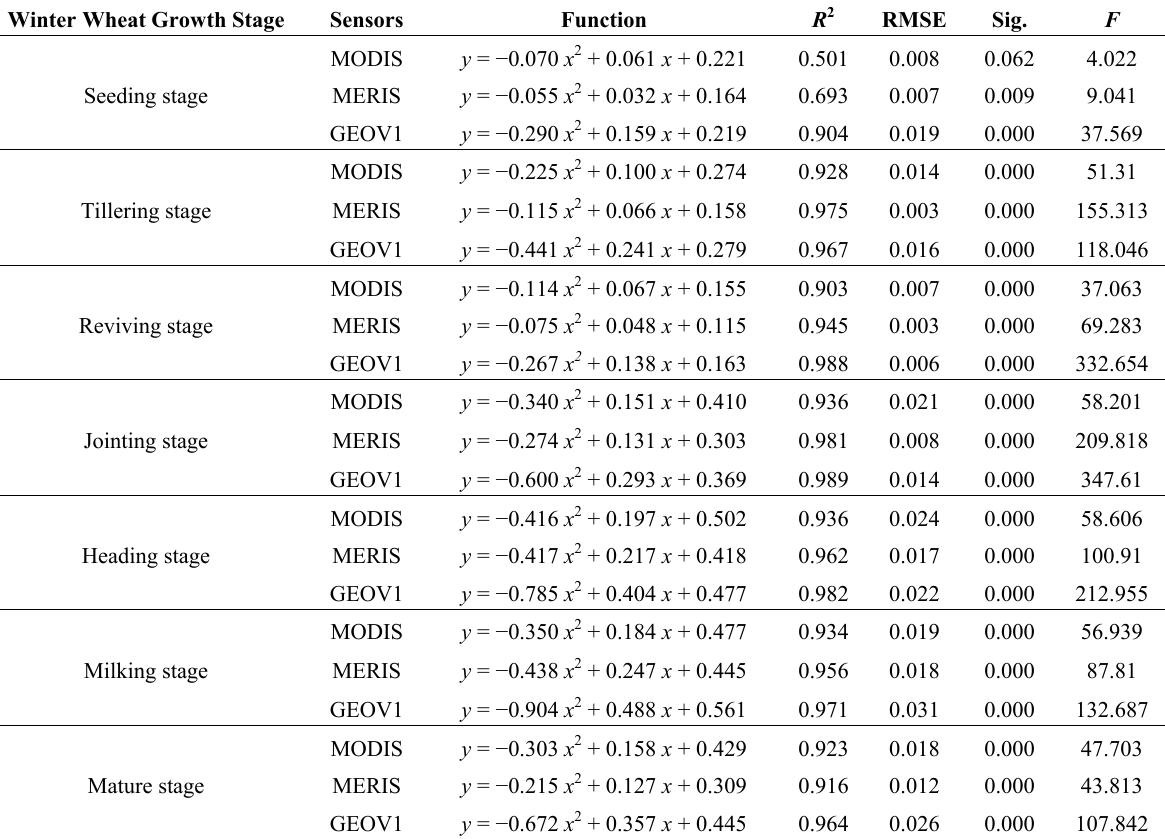
Table 5. The regression between residential area percent and winter wheat FPAR at different